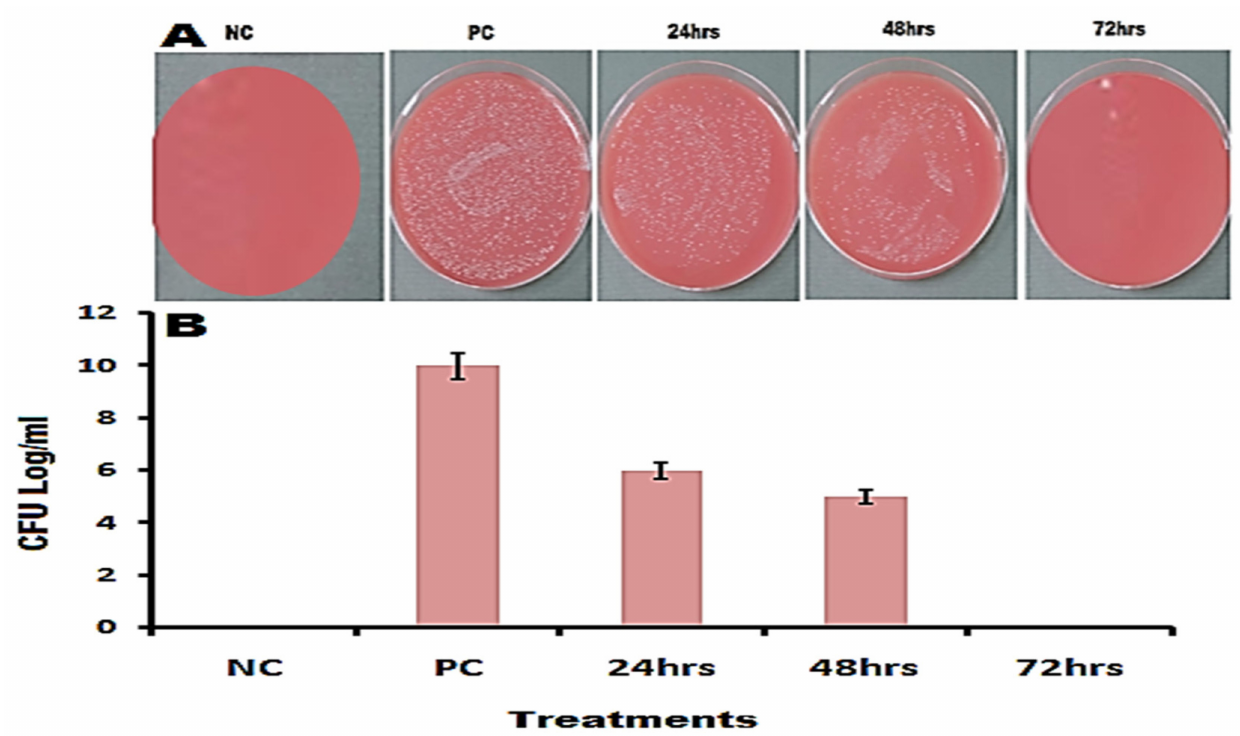
Figure 11. In vivo antibacterial activity of CIP-Ag/TiO 2 /Fe 2 O 3 /CS nanoformulation (NDDS; 0.004 µ g/kg body weight/day = group 4) at indicated time after i.p. induced infection by MDR E. coli cells in rabbits. ( A ) Colonies on blood agar; ( B ) graphical presentation of CFU log in pre-defined groups. PC (positive control) = group 2 (infected but untreated), NC (negative control) = group 3 (non-infected and untreated, containing nutrient broth only). p < 0.05 vs.